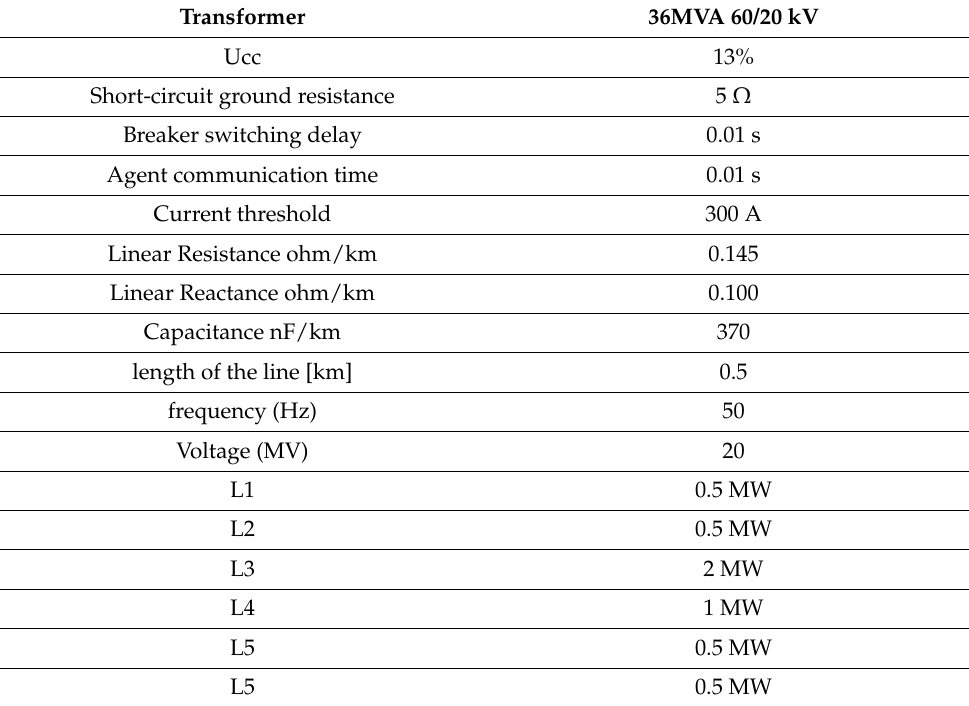
Table 1. Test power system parameters.